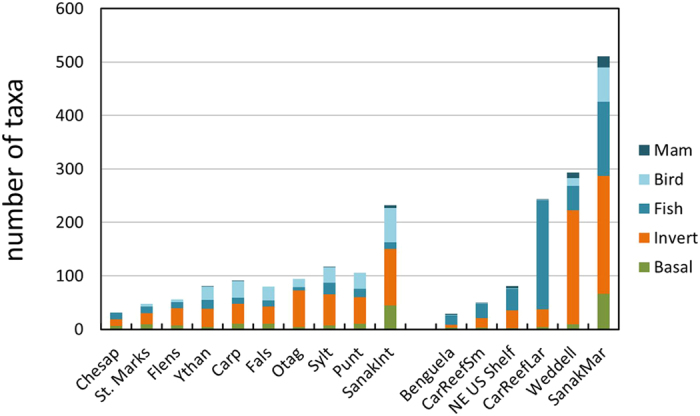
Comparison of diversity and types of taxa in marine food webs.First group shows data for ten coastal webs in order of increasing species richness: Chesap = Chesapeake Bay62; St. Marks = St. Marks Estuary63; Flens = Flensburg Fjord64; Ythan = Ythan Estuary65; Carp = Carpinteria Salt Marsh66; Fals = Bahia Falsa66; Otag = Otago Harbor67; Sylt = Sylt Tidal Basin68; Punt = Estero de Punta Banda66; SanakInt = Sanak Intertidal. Second group shows six marine webs in order of increasing species richness: Benguela = Benguela Fishery69; CarReefSm = Caribbean Reef, small version70; NE US Shelf = Northeast U.S. Shelf17; CarReefLar = Caribbean Reef, large version70; Weddell = Weddell Sea71; SanakMar = Sanak Nearshore. Vertebrate data shown in shades of blue, invertebrate in orange, basal in green. Data shown for trophic species versions of webs, where taxa with the same set of consumers and resources are aggregated into single nodes60. The same figure for original species versions of webs is given in Supplementary Figure S1.